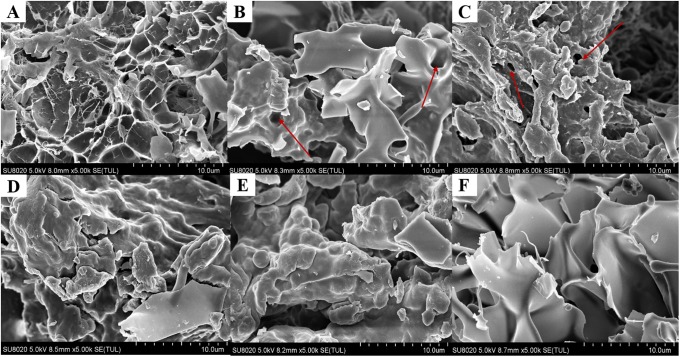
The turbidity and particle size of the β-glucan mixed solutions with different concentrations and ratios under different pressures.(A) The average size of the β-glucan mixed solutions. (B) The turbidity of the β-glucan mixed solutions. Different superscript letters indicate significant differences in the same graph (p < 0.05).